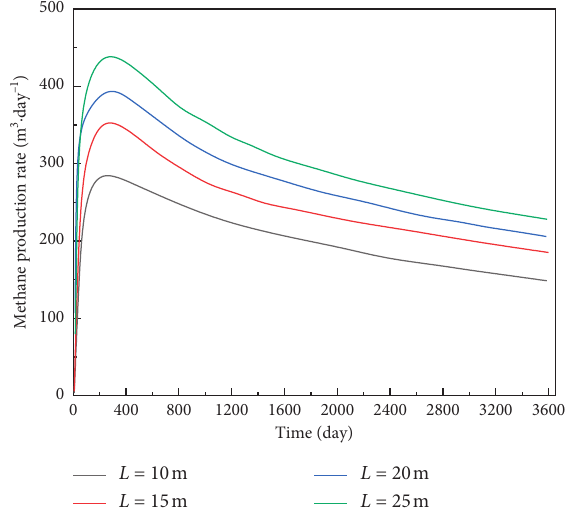
Figure 9: Variation of methane production rate with different fracture length.